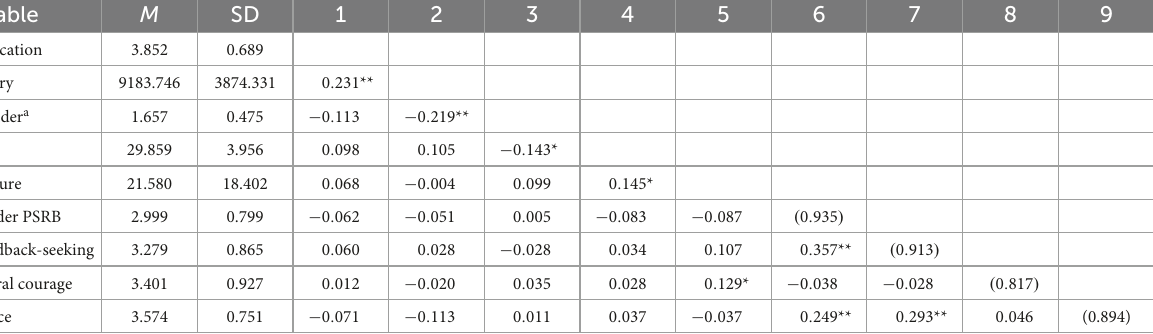
TABLE 1 Means, standard deviations, and correlations.